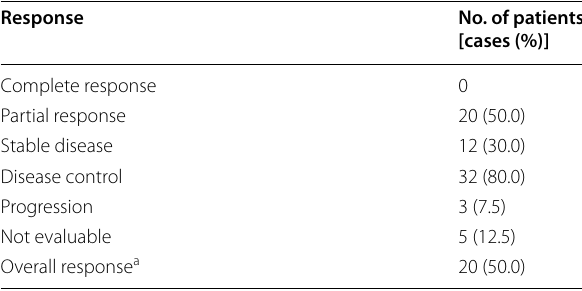
Table 2 The responses of 40 Chinese patients with mCRC to the SOL regimen